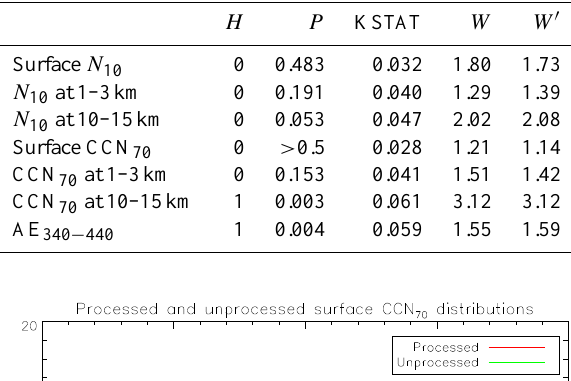
Table 1. Statistics returned by the Lilliefors test and the Brown- Forsythe test on ˚Angstr¨om exponent and on N 10 and CCN 70 at the surface, 1–3km, and 10–15km. If the test statistic KSTAT is larger than 0.05, the null hypothesis that the data are normally dis- tributed is rejected. The null hypothesis is rejected for CCN 70 and AE 340 − 440nm . W and W 0 are the Brown-Forsythe test statistics for unperturbed and perturbed data respectively. If W or W 0 > F α = 1 . 502, the variances are not homogeneous; however, Forbush et al. (1982) say that moderate departures from homogeneous variances will not have a large effect on the results of the tests.